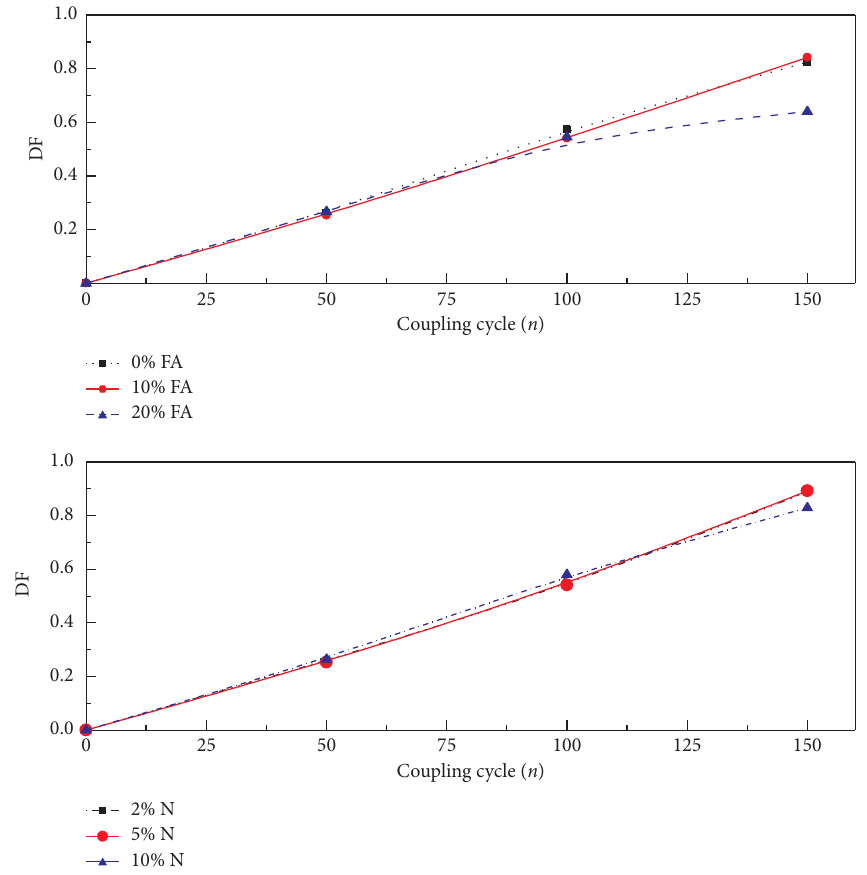
Figure 16: Relationship between DF and coupling